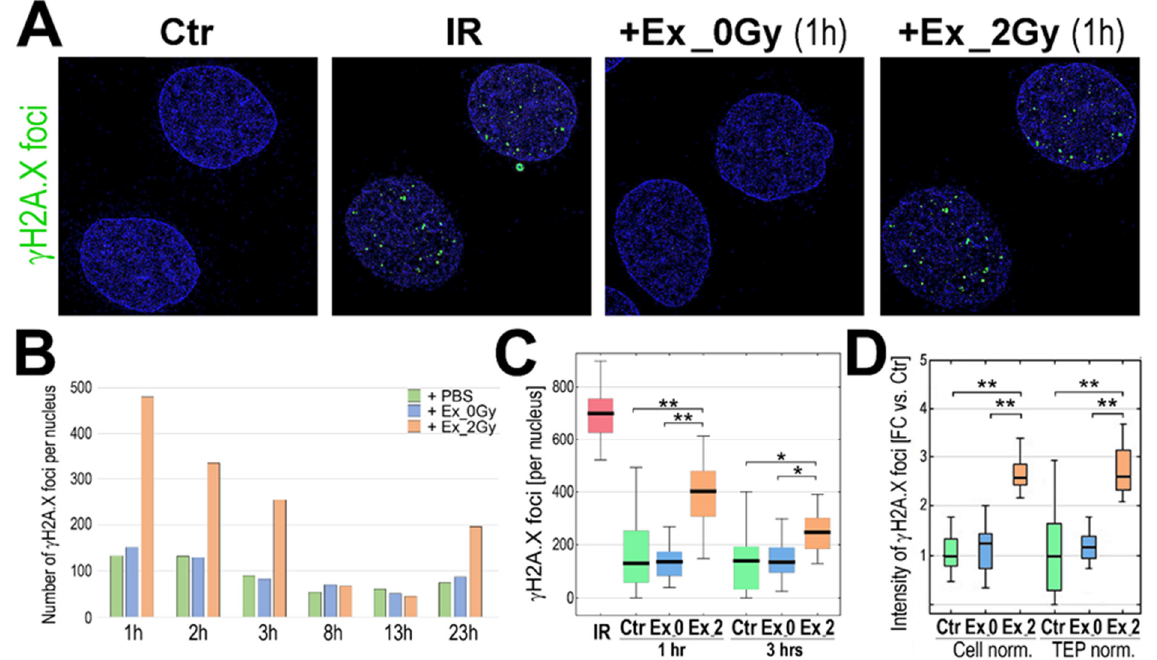
Figure 2. Induction of γ H2A.X foci by exosomes from irradiated cells. ( A ) Visualization of γ H2A.X foci in FaDu cells co-incubated (1 h) with exosomes released by sham-irradiated (Ex_0Gy) or irradiated (Ex_2Gy) cells; untreated cells (PBS control, Ctr) or cells directly irradiated with 2Gy (IR) were used as controls. ( B ) The number γ H2A.X foci after different times of co-incubation with exosomes (1–23 h). ( C ) The number γ H2A.X foci after 1 and 3 h of co-incubation with exosomes; directly irradiated cells (IR) were analyzed 1 h after irradiation. ( D ) The relative intensity of γ H2A.X foci after 1 h of co-incubation; the number of Ex_0Gy and Ex_2Gy exosomes were normalized according to the number of donor cells (Cell norm.) or according to the total exosome proteins (TEP norm.); the nucleus-integrated intensity was expressed as a fold-change versus PBS-treated controls (FC vs. Ctr). Box plots show the median, minimum, maximum, and lower and upper quartiles; statistically significant differences between groups are represented by asterisks: * p < 0.05 and ** p < 0.001 (only differences between Ctr and exosome-stimulated cells are shown for clarity).